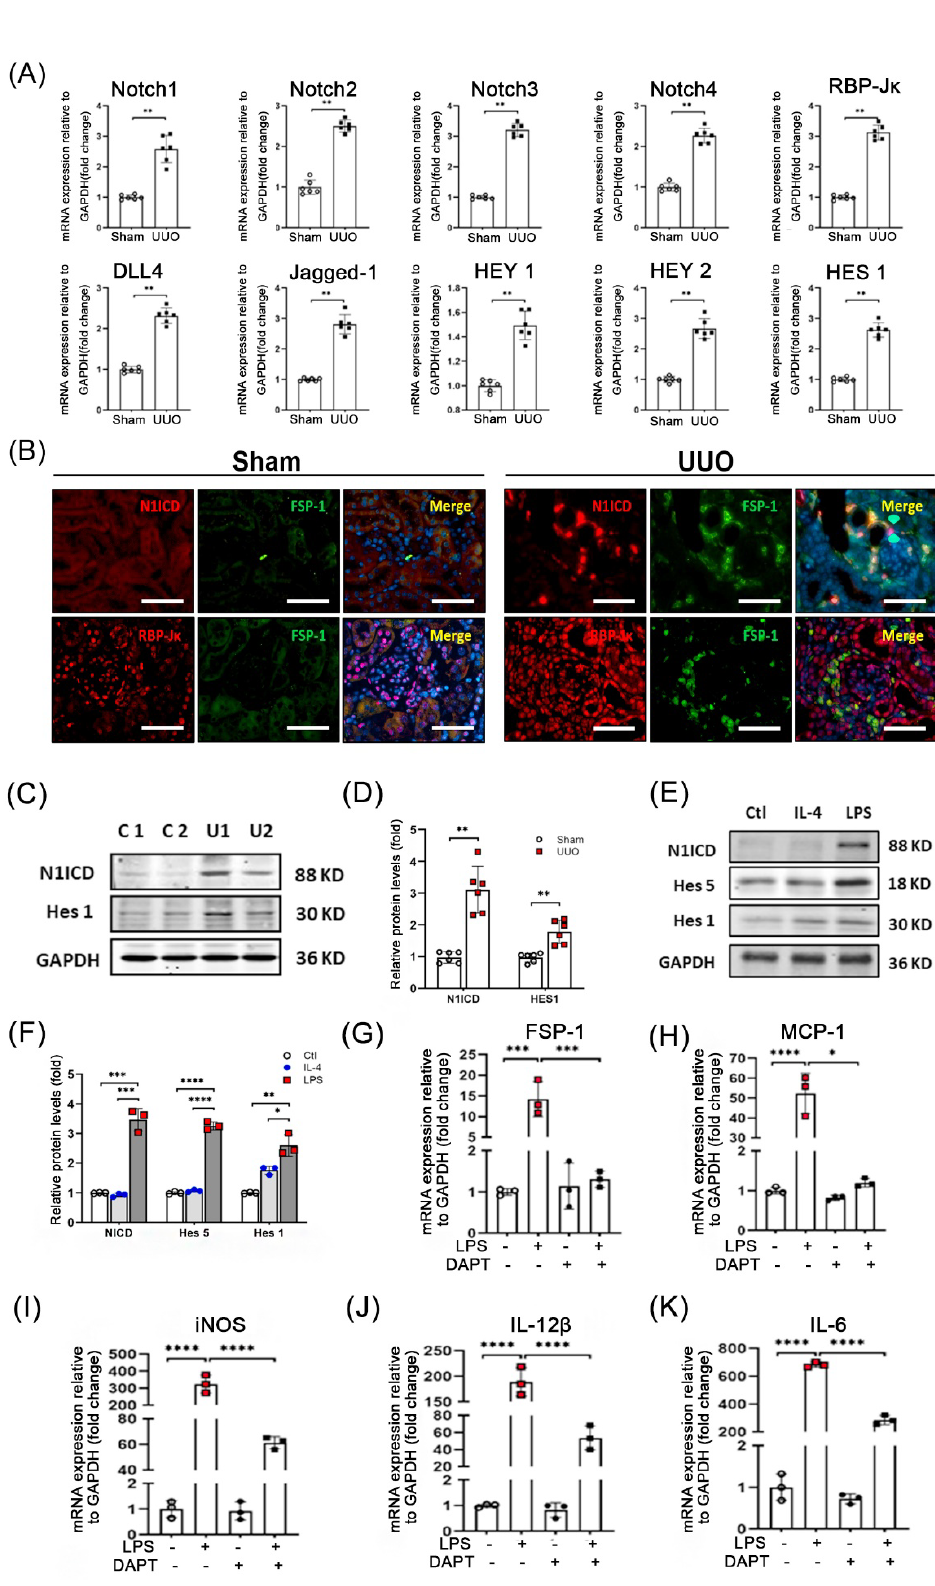
Figure 4. Notch signaling pathway was activated in kidneys after UUO. ( A ). Relative mRNA levels of molecules in Notch signaling pathway were determined by qRT-PCR in mice 7 days following UUO. Gene expression levels were normalized to mRNA levels of control animals, and significance was calculated (**, p < 0.005). ( B ). Double immunostaining of FSP-1 with N1ICD or RBP-J κ was